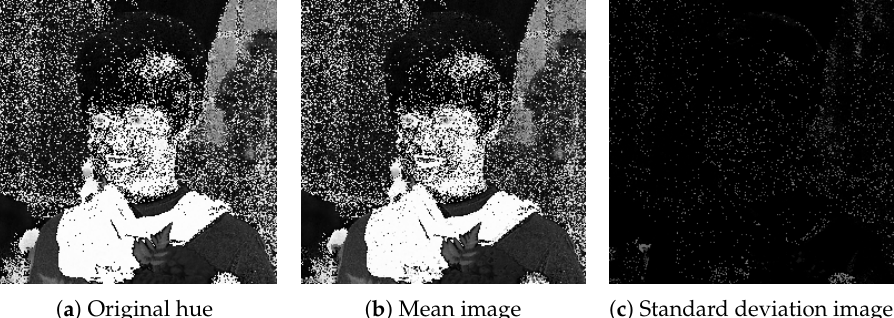
Figure 10. Mean and standard deviation of hue values of the six images in Figure 9 compared with the original hue image ( a ) computed from the input color image in Figure 2a: ( b ) the mean image of Figure 9a–f, and ( c ) their standard